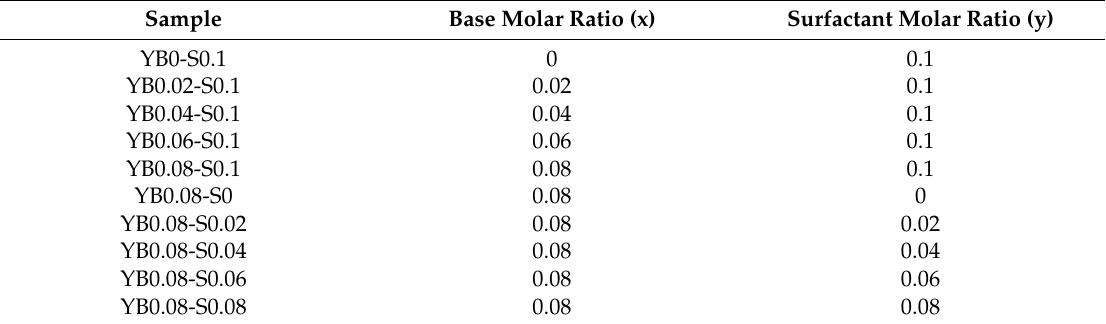
Table 1. Modification conditions used for preparation of the